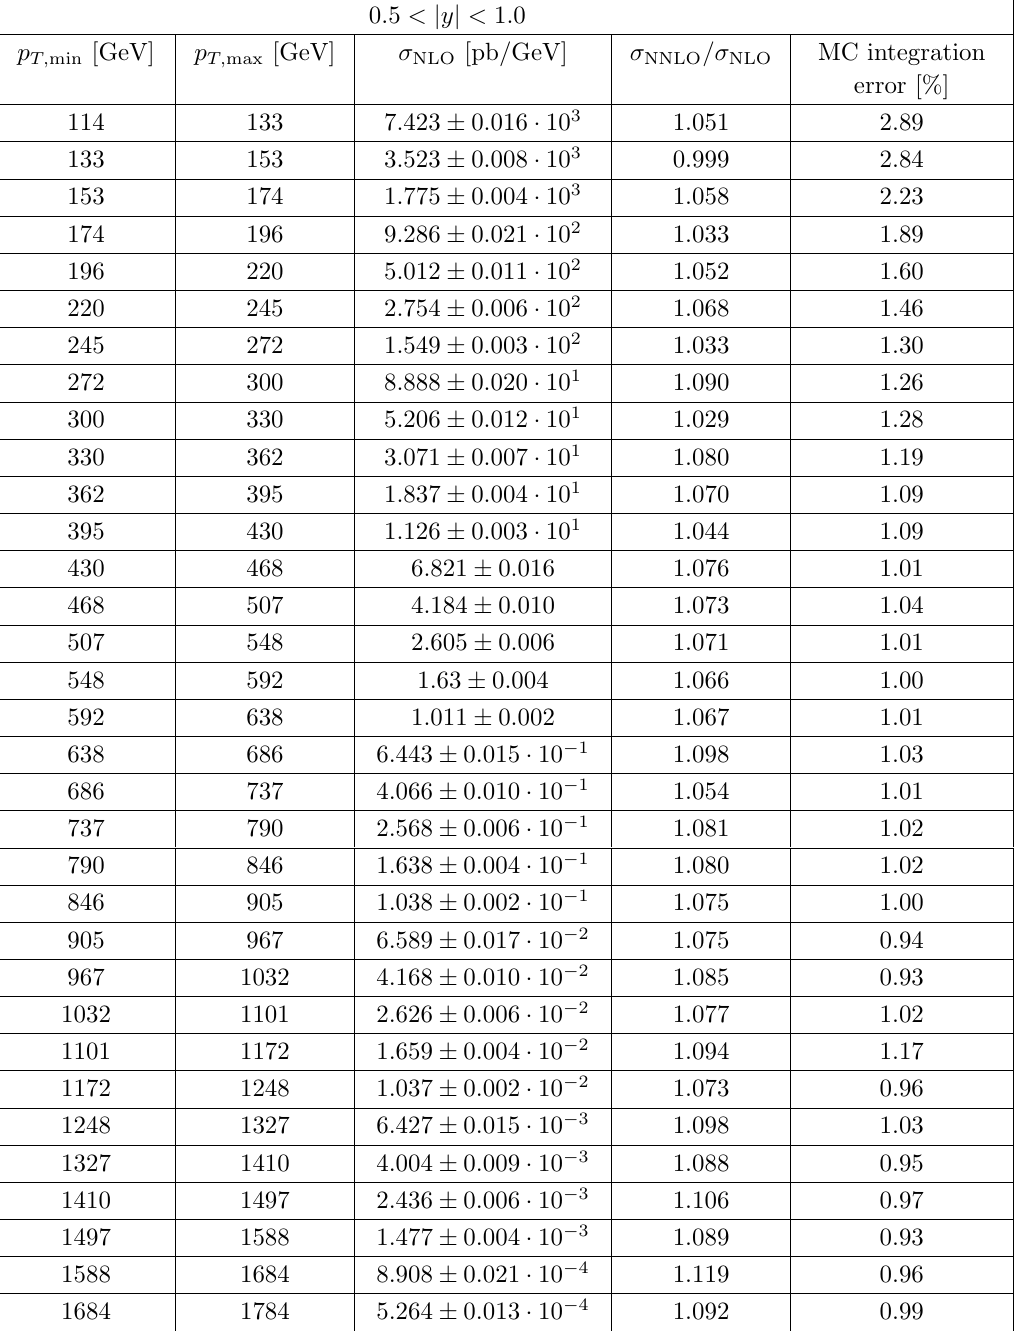
Table 2 . NLO QCD single-inclusive cross section and NNLO QCD K-factors in the rapidity slice y < 1 : 0 : 5 < j j